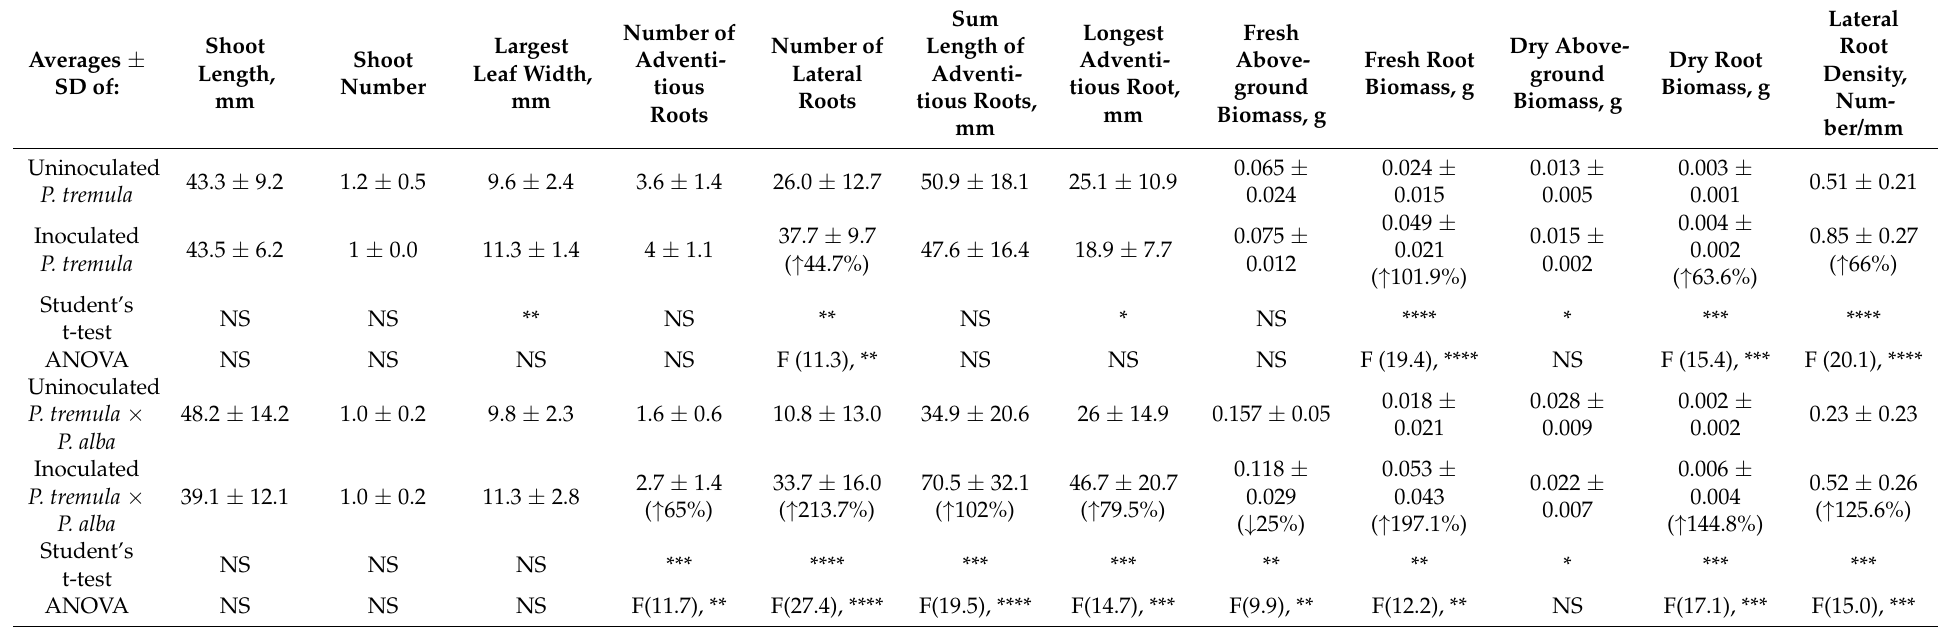
Table 2. Microshoot growth parameter measurements taken after 2 months of incubation and their statistical analysis